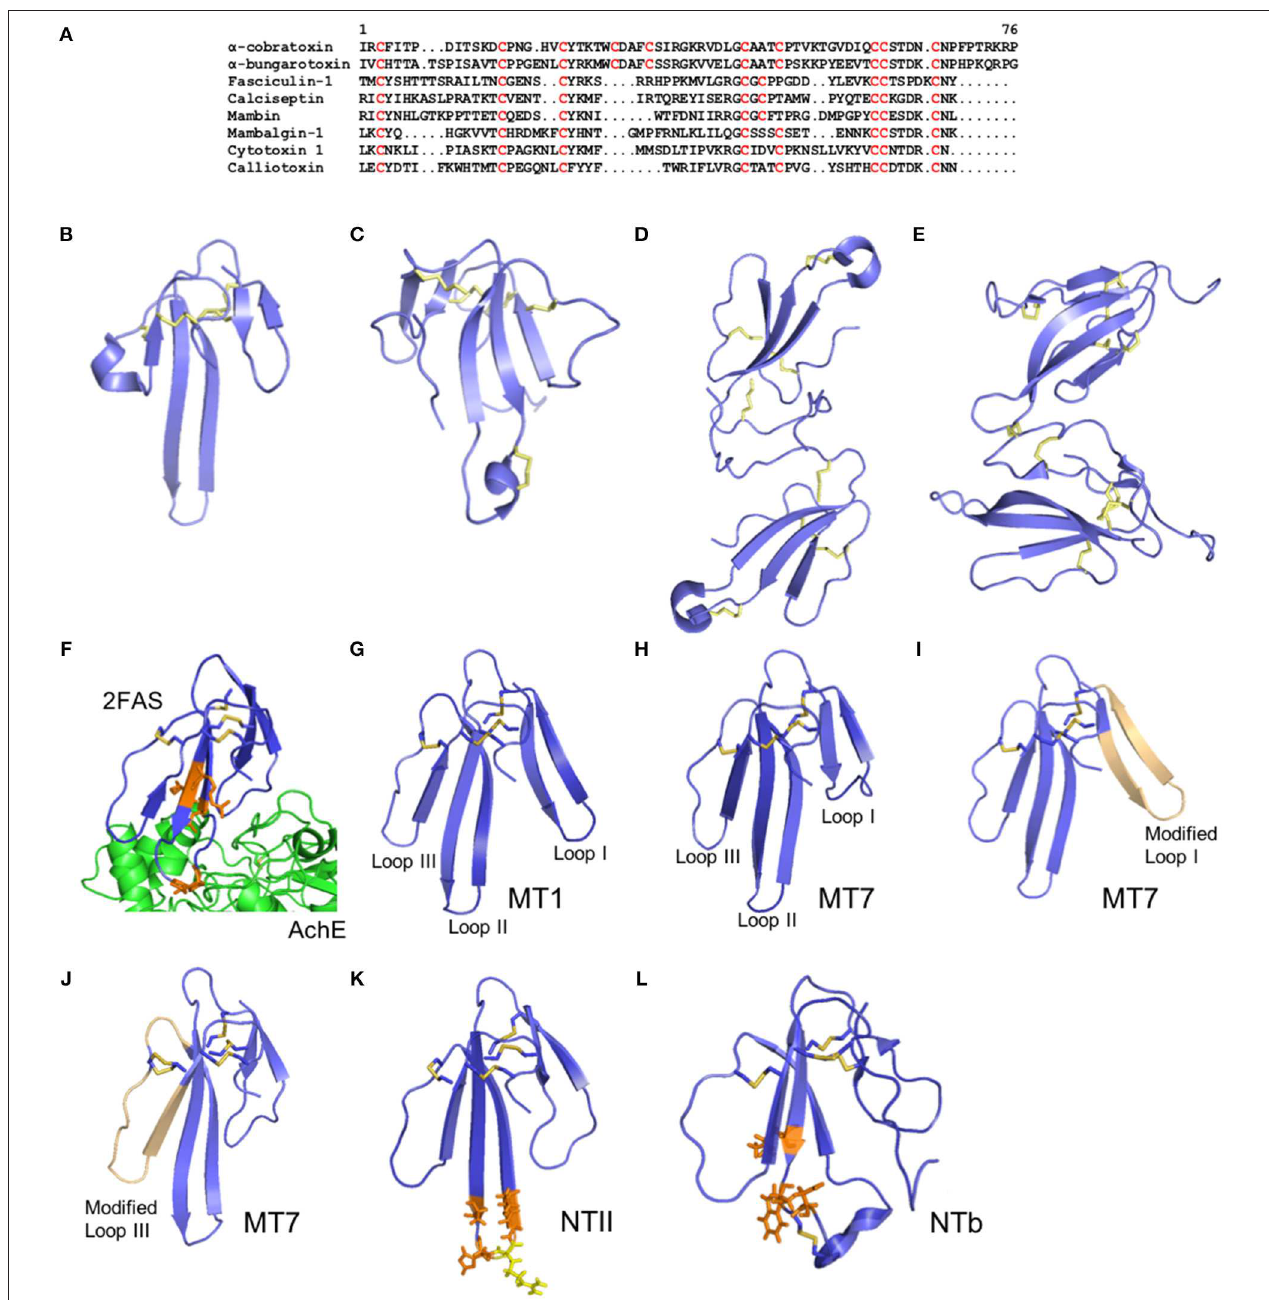
FIGURE 4 | Structure of three-finger toxins from snake venoms. (A) Alignment of the primary structure of α -cobratoxin from Naja kaouthia (Uniprot P01391), α -bungarotoxin from Bungarus multicinctus (Uniprot P60615), fasciculin from Dendroaspis angusticeps (Uniprot P0C1Y9), Calciseptin from Dendroaspis polylepis polylepis (Uniprot P22947), mambin from Dendroaspis jamesoni kaimosae (Uniprot P28375), mambalgin-1 from Dendroaspis polylepis polylepis (Uniprot P0DKR6), cytotoxin 1 from Naja atra (Uniprot P60304), and calliotoxin from Calliophis bivirgatus (Uniprot P0DL82). (B–E) Cartoon representation of the three-dimensional structure of the 3FTXs short-chain mambalgin-1 from Dendroaspis polylepis polylepis (PDB 5DU1) (B) , long-chain α -bungarotoxin from Bungarus multicinctus (PDB 1ABT) (C) , non-covalent homodimer α -cobratoxin from Naja kaouthia (PDB 4AEA) (D) , and covalent heterodimer irditoxin from Boiga irregularis (PDB 2H7Z) (E) . (F) Cartoon representation of the three-dimensional structure of Fascilulin-2 bound to the AChE (PDB 4BDT). The residues Arg24, Lys25, Pro31 and Leu35 which form hydrogen bonds with AChE are shown in orange. (G–J) Cartoon representation of the three-dimensional structure of the muscarinotoxin 1 (MT1, PDB 4DO8) (G) and muscarinotoxin 7 (MT7, PDB 2VLW) (H) , and respective analogs displaying the modified loop 1 (PDB 3FEV) (I) and loop 3 (PDB 3NEQ) (J) in light orange color. (K) Neurotoxin II from N. oxiana (PDB 1NOR). The residues Ser29, His31, Gly33 and Thr34 which form hydrogen bonds with the α -subunit of nAChR are shown in orange, and the residue Arg32 forming ionic interactions with the α -subunit of nAChR is shown in yellow. (L) Neurotoxin b (NTb) from O. Hannah (PDB 1TXA). The residues Lys24, Trp26, and Asp28 that form hydrogen bonds with the α -subunit nAChR are shown in orange.